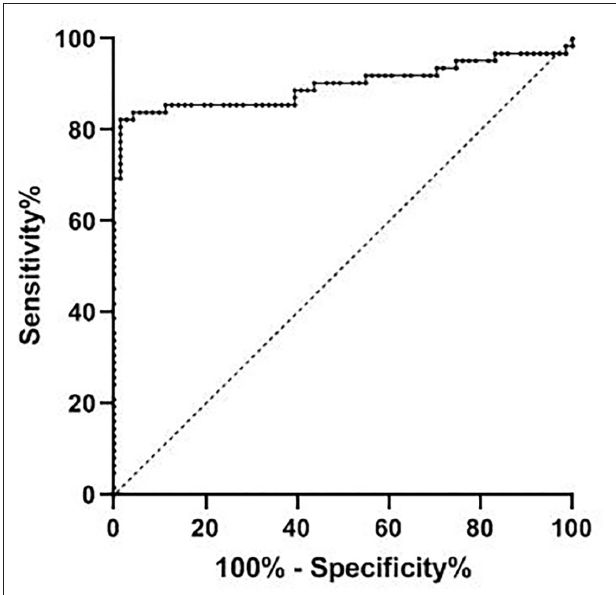
FIGURE 3 | Diagnostic efficacy of CEBPA level in ovarian cancer. CEBPA, CCAAT enhancer-binding protein alpha.